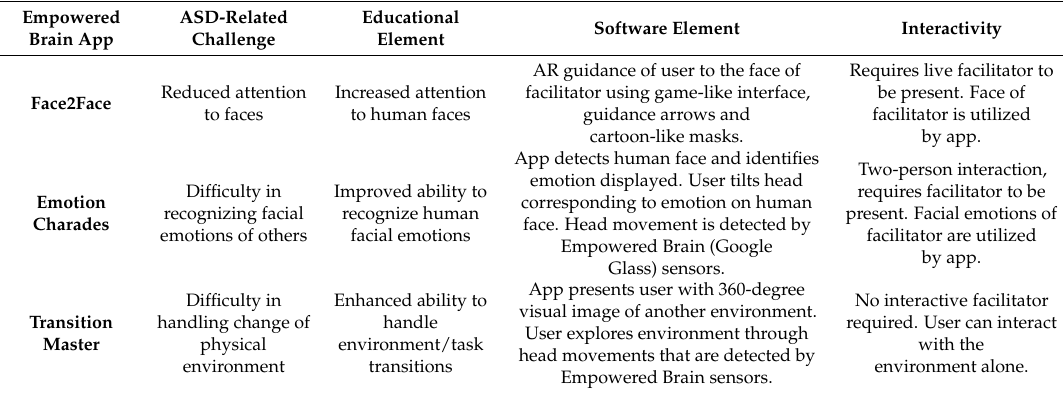
Table 1. Intervention focus of Empowered Brain Software